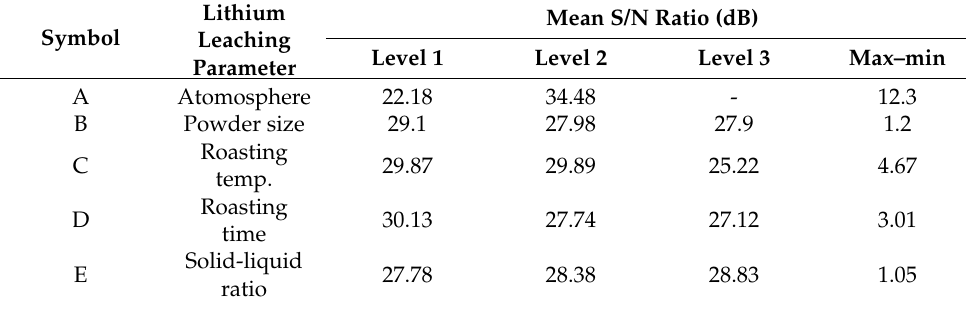
Table 5. S/N response table for lithium leaching